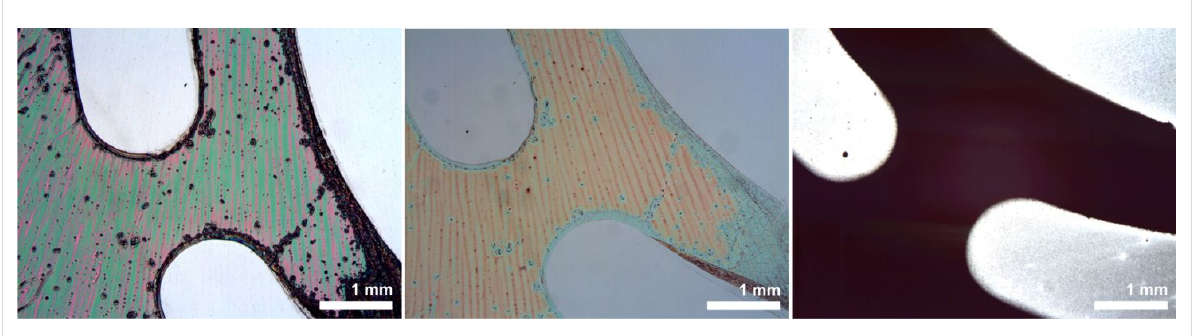
Figure 12: Optical microscopy images of the different steps of the irradiation-induced pattern formation. Left: The “liquid bright gold” film after UV ir- radiation and washing with dichloromethane. Center: The same area after annealing at 650 °C. Right: The pattern is reproduced after 1 h of treat- ment with NPS at 650 °C. The bright areas are due to the high reflectivity of the uncovered Si substrate.